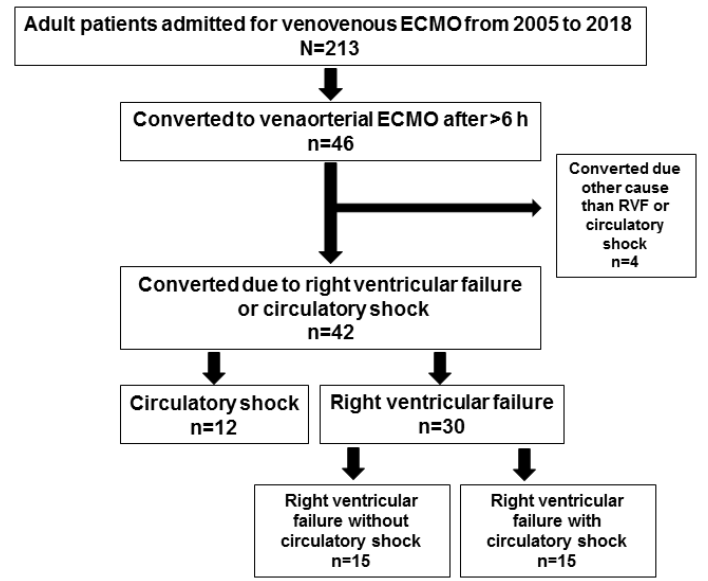
Figure 1. Consort diagram of the retrospective selection of patients. ECMO: extracorporeal membrane oxygenation; RVF: right ventricular failure. Table 1. Converted and non-converted patients. Baseline and outcome data for non-converted and converted venovenous extracorporeal membrane oxygenation patients. This table includes all 46 patients. * RESP score at the time of decision for ECMO; ** Tidal volume for the non-converted group was based on the lowest volume noted during ECMO treatment, while the tidal volume for the converted group was based on the lowest volume at the time of diagnosis and when the decision for conversion was made. Data was collected from digital medical charts.; # missing or incomplete medical charts, n = 6. Abbreviations: Circ.: circulatory; ECMO: extracorporeal membrane oxygenation; RESP: Respiratory Extracorporeal membrane oxygenation Survival Prediction score; RVD: right ventricular dysfunction; RVF: right ventricular failure; SAPS-3: Simplified Acute Physiology Score.